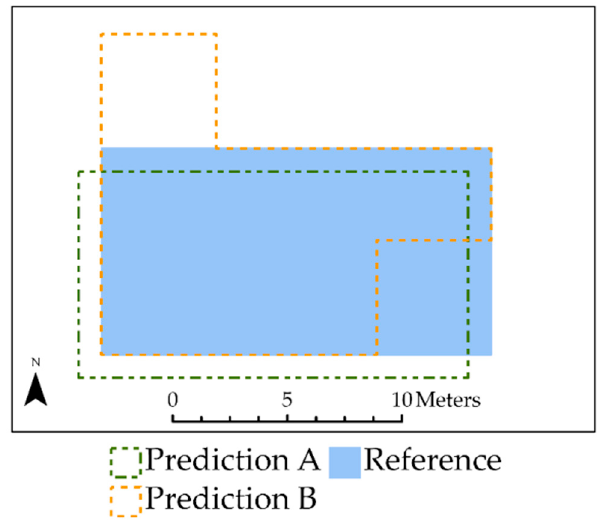
Figure 4. Synthetic data to demonstrate the limitations of standard area-based accuracy assessment for differentiating the spatial pattern of disagreement.